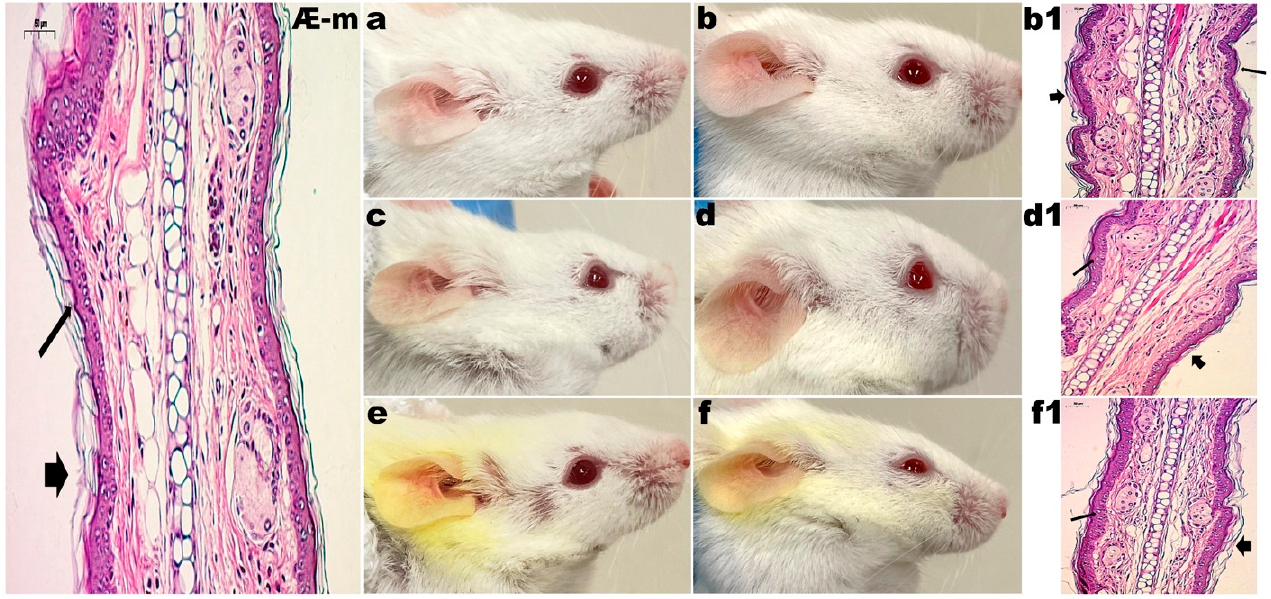
Figure 2. Results obtained after application of the formulations in the ears of male mice. ( a ) (G2) 10 days of LBG (2%, w/w ) gel application; ( b ) (G2) 20 days of LBG (2%, w/w ) gel application; ( c ) (G3) 10 days of application of LBG gel (2%, w/w ) with CUR (2%, w/w ); ( d ) (G3) 20 days of application of LBG gel (2%, w/w ) with CUR (2%, w/w ); ( e ) (G4) 10 days of application of LBG gel (2%, w/w ) with CUR (2%, w/w ) and CAGE-IL (2%, w/w ); ( f ) (G4) 20 days of application of LBG gel (2%, w/w ) with CUR (2%, w/w ) and CAGE-IL (2%, w/w ); ( Æ - m ) (G1) photomicrograph (x200 magnification) of histological section of mouse ear skin of male absolute control; ( b1 ) (G2) photomicrograph (×200 magnification) of histological section of mouse ear skin after 20 d of application of LBG gel (2%, w/w ); ( d1 ) (G3) photomicrograph (×200 magnification) of histological section of mouse ear skin after 20 d of application of LBG gel (2%, w/w ) with CUR (2%, w/w ); ( f1 ) (G4) photomicrograph (×200 magnification) of histological section of mouse ear skin after 20 d of application of LBG gel (2%, w/w ) with CUR (2%, w/w ) and CAGE-IL (2%, w/w ). The histological sections were stained with hematoxylin and eosin. For the significance of the inserted (thick, thin and arrowhead) arrows, please refer to the Discussion section. Scale bar represents 50 µm. Note: the yellowish color observed in the fur of the animals is due to the use of the gel with CUR and CAGE-IL, with the ionic liquid promoting a greater solubility of CUR and consequently dying the fur.